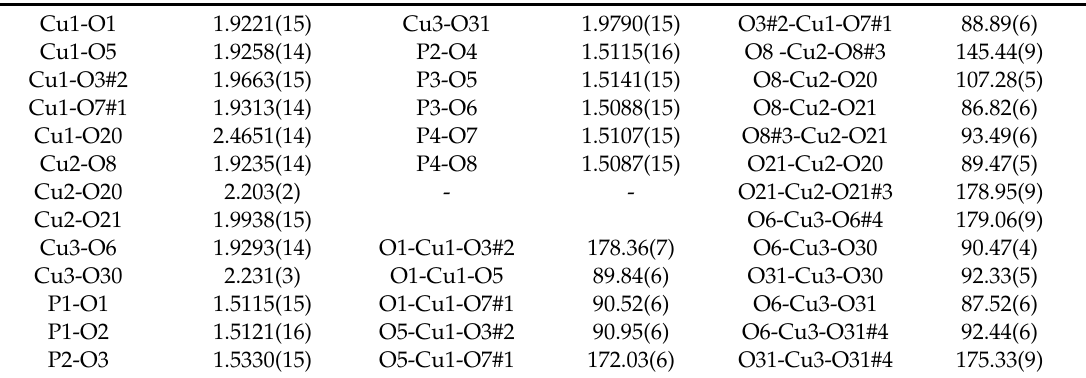
Table 2. Selected bond lengths (Å) and angles ( ◦ ) for 2 . Symmetry transformations used to